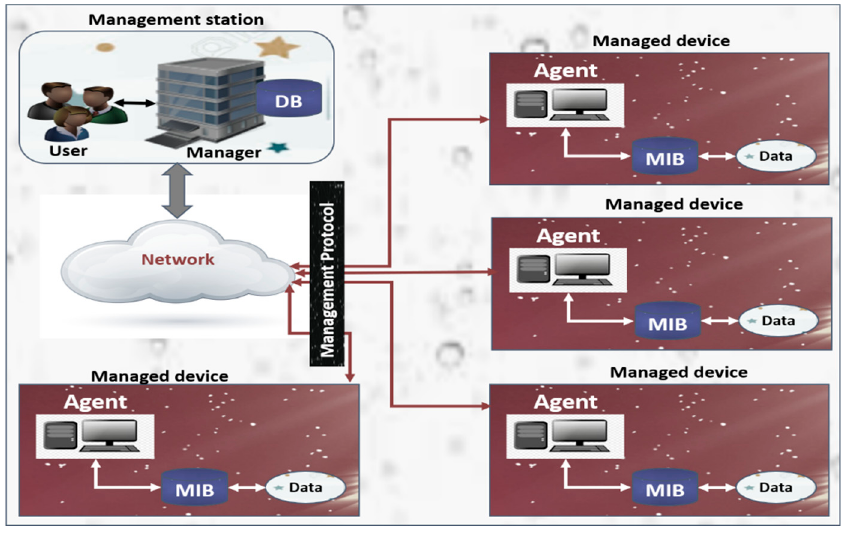
Figure 1. Network management system components.